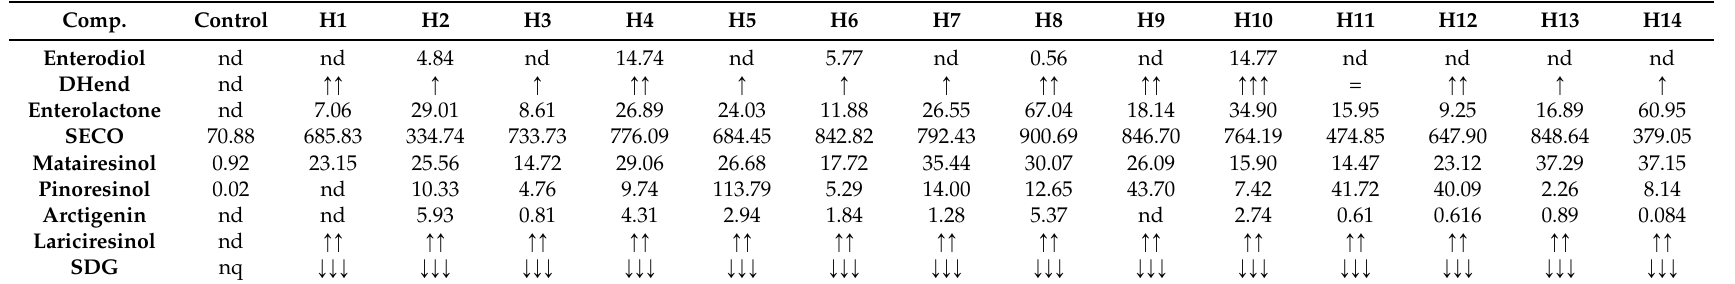
Table 3. Metabolism of lignans ( µ M) by adult human gut